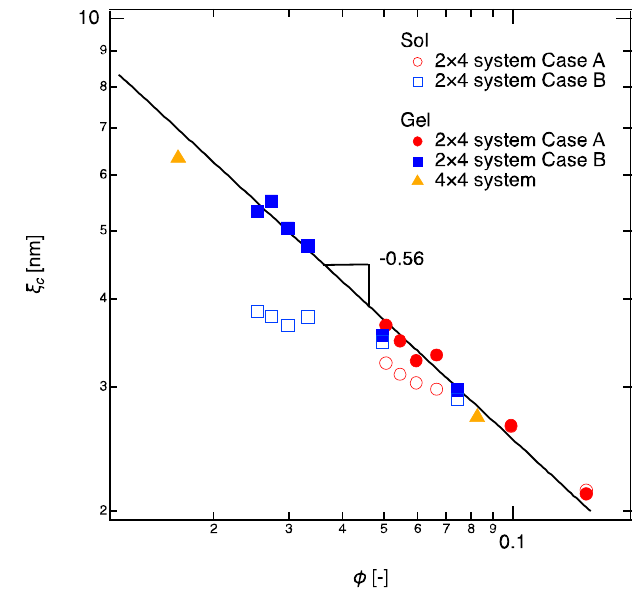
Figure 3. Size of correlation blob in 2 × 4 gels as a function of the total polymer volume fraction ( φ = φ 2 + φ 4 ). The full symbols represent the gels and empty symbols represent the sols. Data of Case A are shown in red and those of Case B are shown in blue. Sol samples were prepared as controls by using the non-reactive tetra-PEGs and linear-PEGs. 4 × 4 gels are also shown as controls. The solid line illustrates the fitting curve, ξ c ∼ φ − 0.56